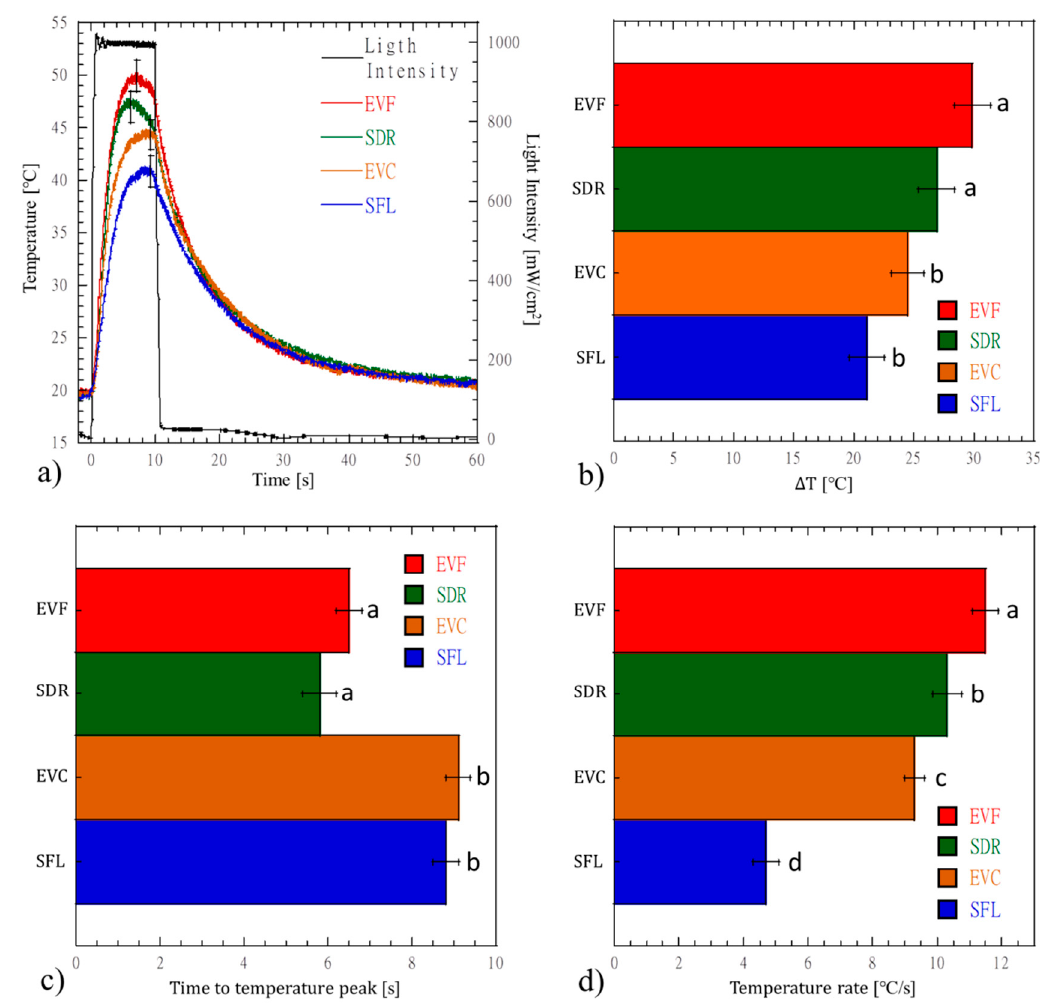
Figure 2. ( a ) Temperature profiles developing into bulk-fill RBC; ( b ) maximum temperature rise; ( c ) time to temperature peak; and ( d ) temperature rate. Error bars represent the standard deviation. Different letters reported beside the bars indicate a significant difference between the means ( p < 0.05).